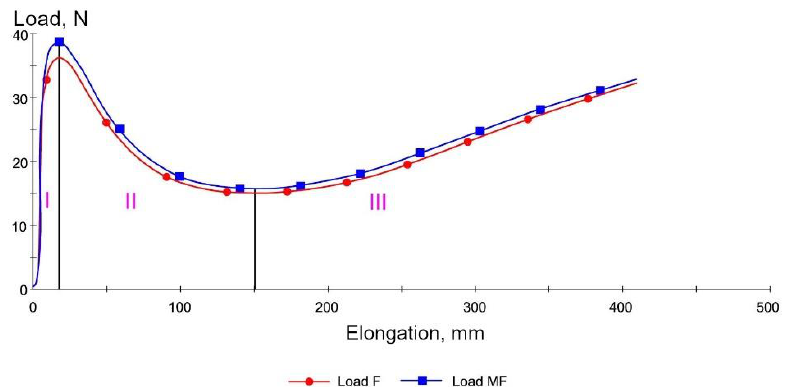
Figure 13. Load vs. elongation curves of bitumen 35/50 modified with 5% of SBS-R copolymer.